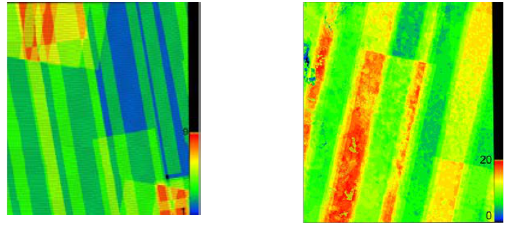
Figure 16: number of covers (colour scale on lower right), left: TDM90, right: AW3D30